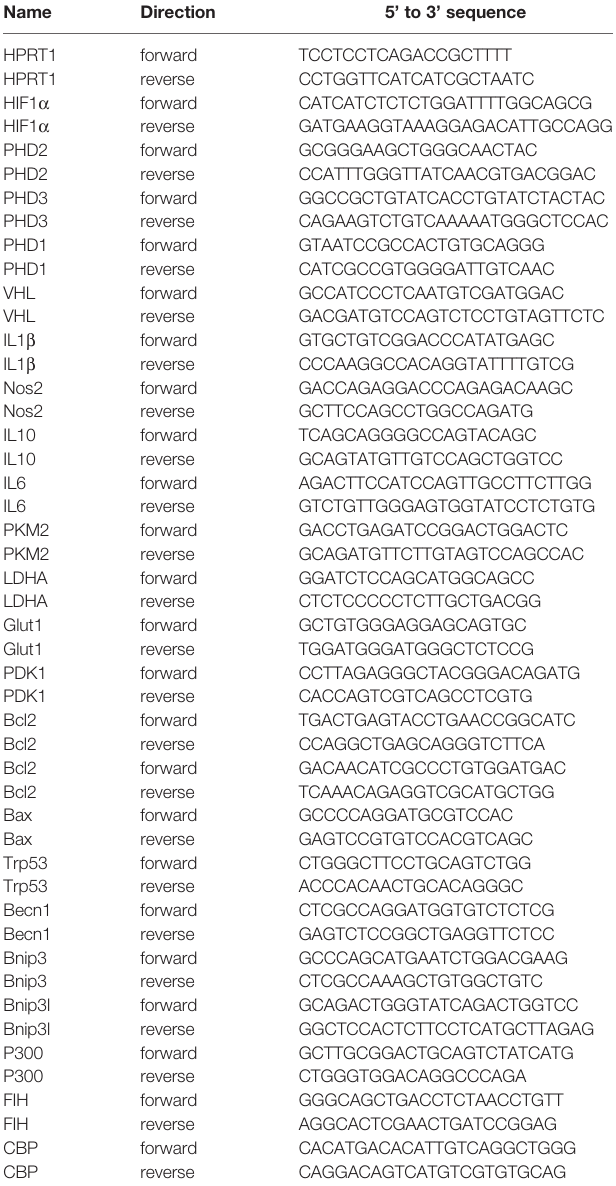
TABLE 1 | Primers